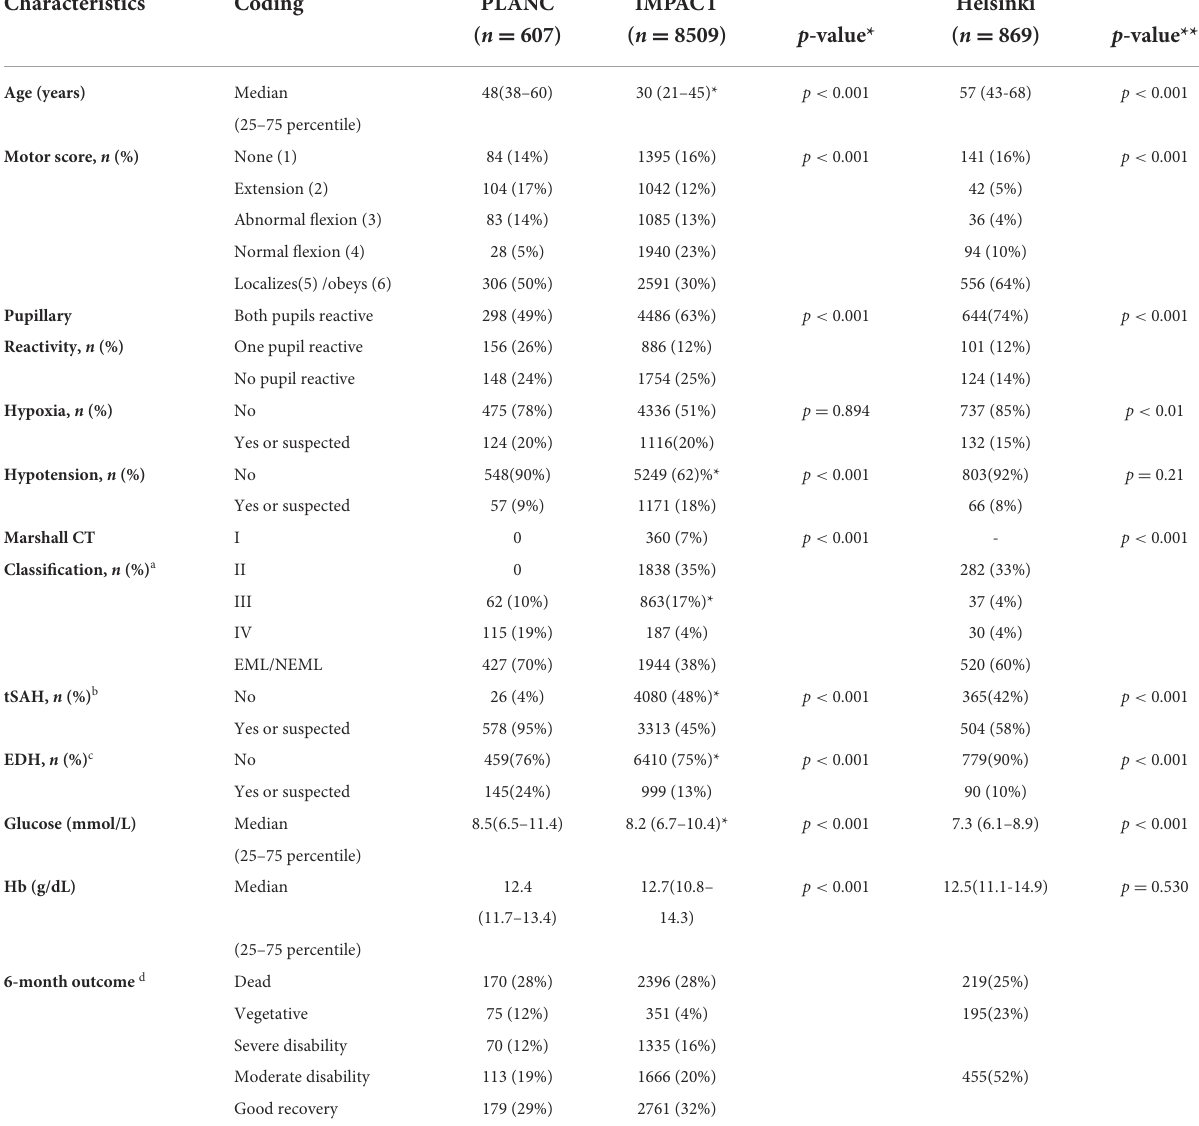
TABLE 2 Characteristics of patients in IMPACT study (no imputation of missing values), Helsinki and PLANC cohorts. Characteristics